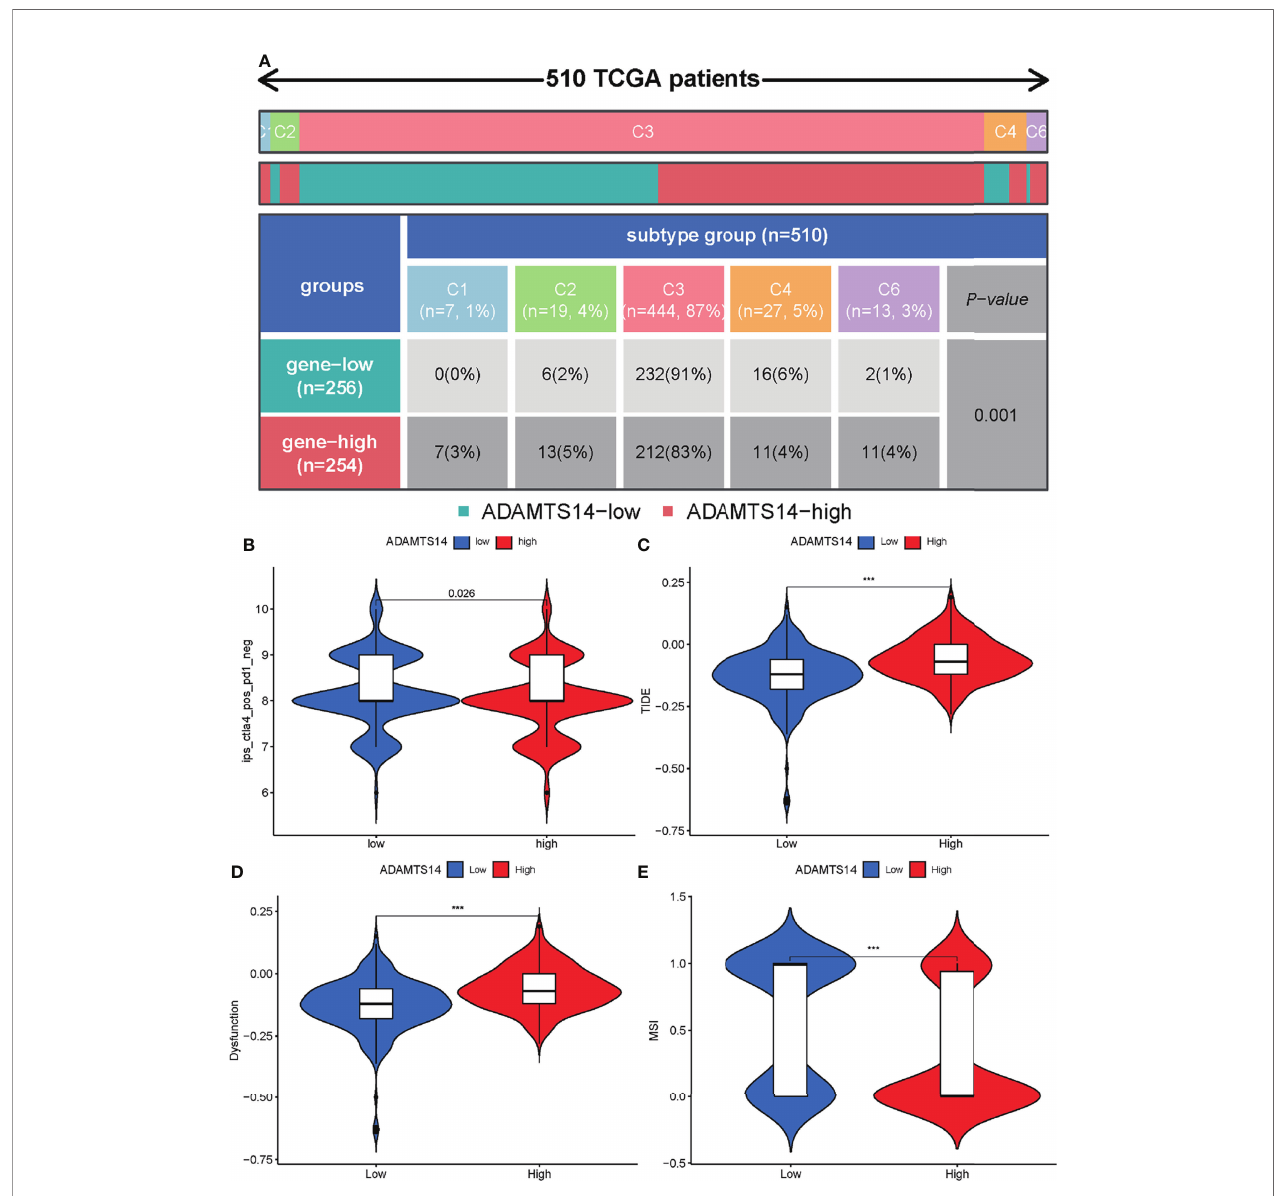
FIGURE 9 | Prediction of ADAMTS14-related immune responses of immunotherapy in ccRCC patients. (A) Distribution of ADAMTS14 expression in pan-cancer immune subtypes in TCGA dataset. (B) Distribution of ADAMTS14 expression in CTLA4 scores by TCIA dataset. (C) Distribution of ADAMTS14 expression in TIDE scores by TIDE dataset. (D) Distribution of ADAMTS14 expression in T-cell dysfunction scores by TIDE dataset. (E) Distribution of ADAMTS14 expression in MSI scores by TIDE dataset. *** p <